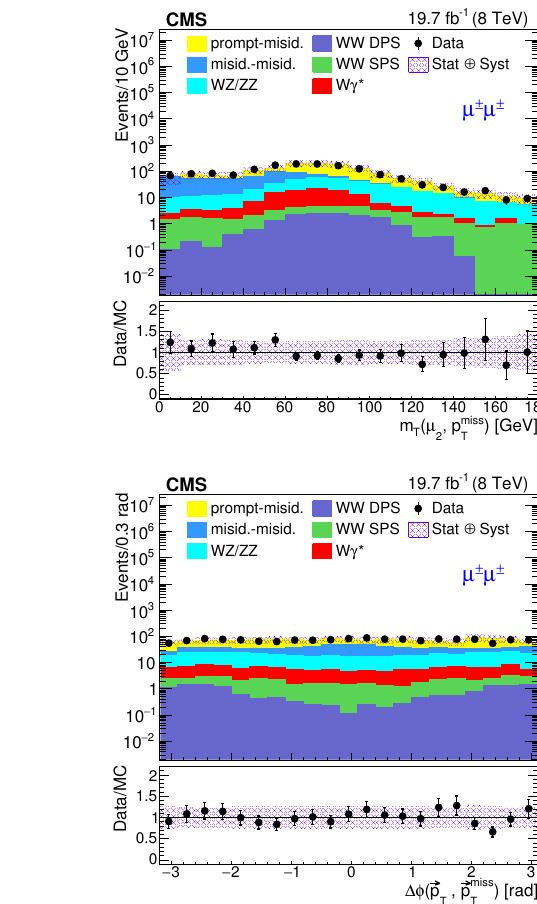
Figure 2 . Distributions of the p T (top-left), m T ( (cid:22) 2 ; p miss ) (top-right), (cid:1) (cid:30) ( ~p T ; ~p T ) (bottom- T 2 1 2 left), and (cid:1) (cid:30) ( ~p T ; ~p miss ) (bottom-right) variables for the dimuon channel, after the same-sign WW T 2 selection criteria have been applied. The data are represented by the black dots and the shaded histograms represent the predicted signal and background processes normalized according to the estimated cross sections and the luminosity. For each individual distribution, the bottom panels show the ratio of the number of events observed in the data to that predicted by the simulation, along with the associated statistical uncertainty. The hatched bands in all cases represent the sum of the systematic and statistical uncertainties of the simulated samples, added in